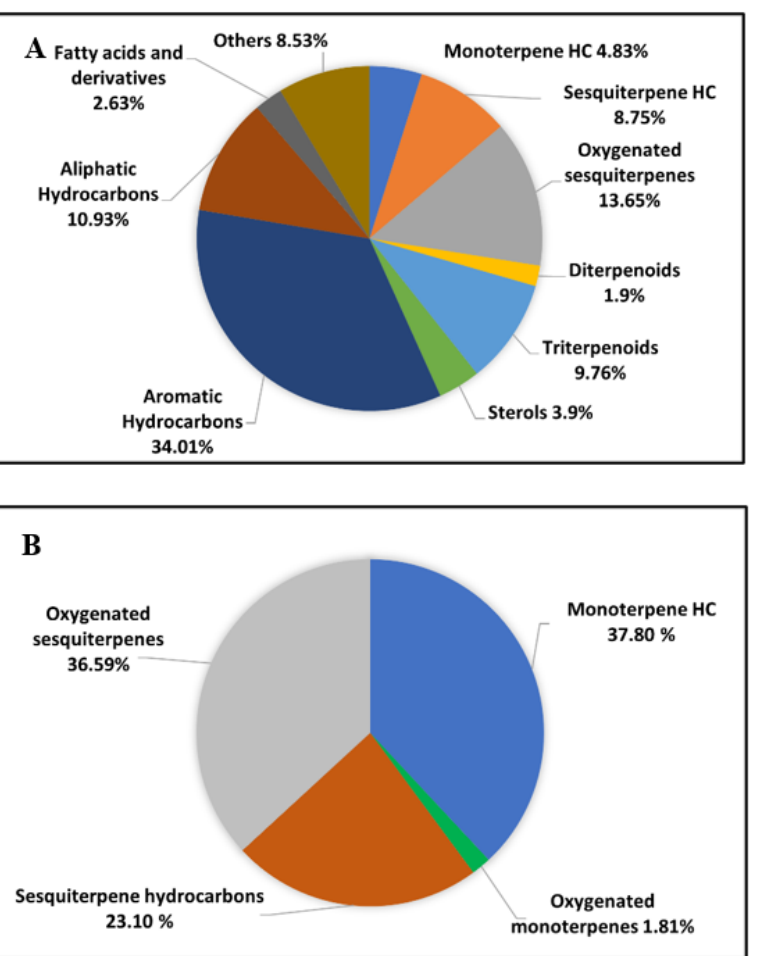
Figure 2. Chemical structures of the major constituents identified in the n -hexane extract and essen- tial oil of Psidium guajava leaves using GC/MS analysis.